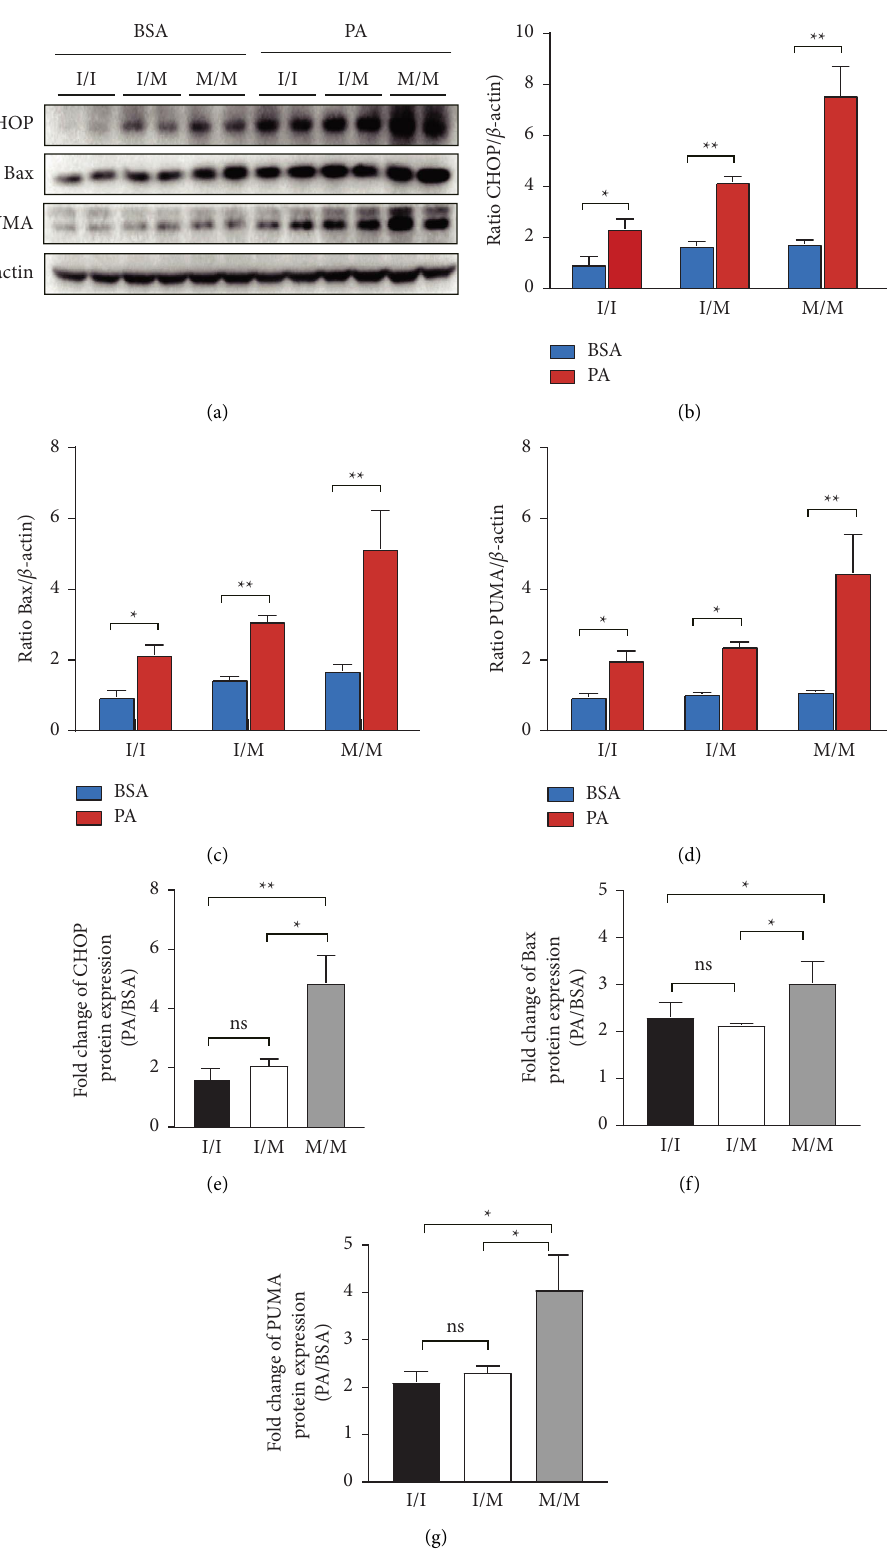
Figure 4: The protein expression of molecules involved in the CHOP apoptotic pathway. (a) The protein level of Bip, bax, and PUMA detected by western blot. (b–d) The quantitative analysis of gray value based (a) performed using image-pro plus software. (e–g) Fold change (PA/BSA) of (b–d). Biological replicates ( N � 3) were performed per group. Quantitative data are presented as the mean ± SD ( N � 3 independent experiments). ∗ P < 0 . 05; ∗∗ P < 0 .